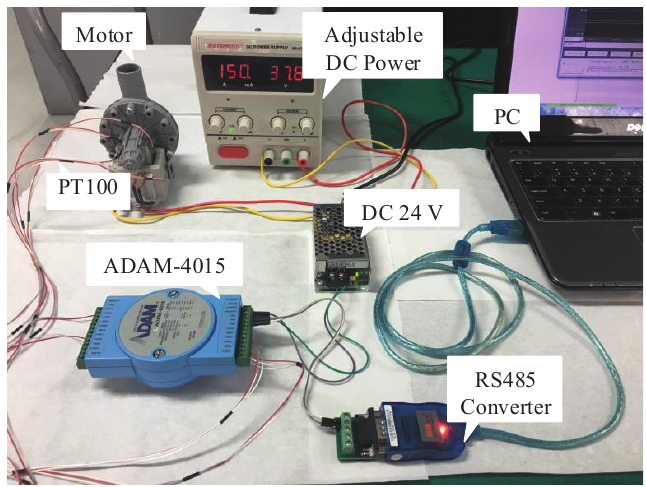
Figure 18. Experimental platform for temperature test.